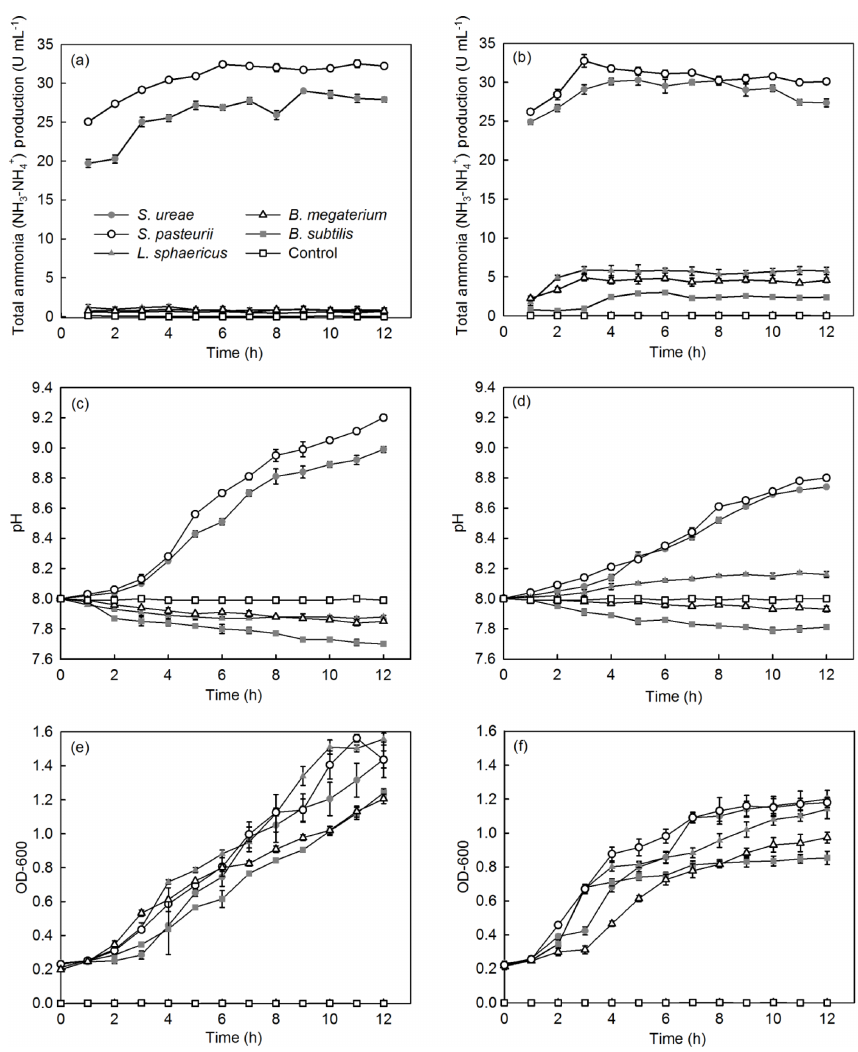
Figure 2. (a, b) NH 3 –NH + production (UmL − 1 : µmol of NH 3 –NH + min − 1 mLOD 600 of culture); (c, d) pH; and (e, f) growth of selected 4 4 bacteria types in (a, c, e) UB-1 (no yeast extract, YE) and (b, d, f) UB-2 (10gL − 1 YE) nutrient conditions (SD, n = 6). YE was a nitrogen source in the growth